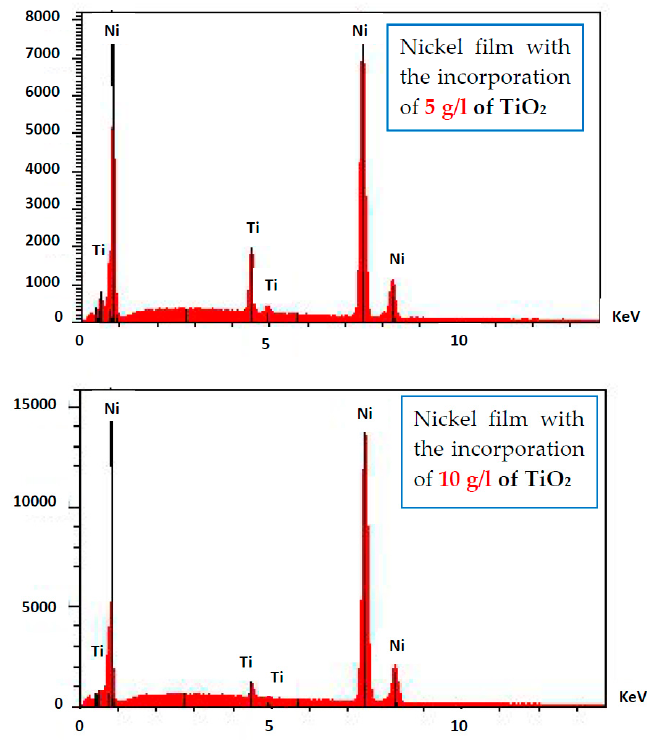
Figure 7. energy dispersive X-ray spectrometry (EDS) Spectra of the electrodeposited Ni–TiO 2 alloys (5 g/L of TiO 2 and 10 g/L of TiO 2 ).